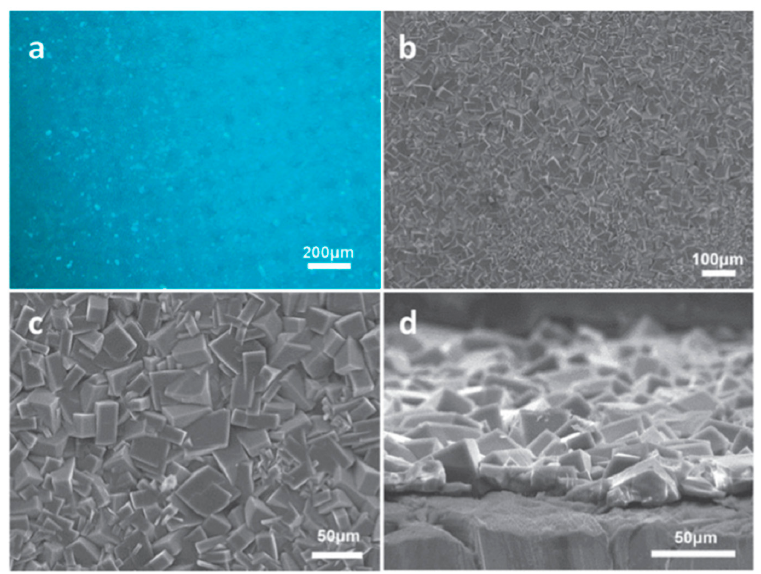
Figure 3. Leica picture of ( a ) the Ni 2 (L-asp) 2 (bipy) membrane; SEM pictures of ( b , c ) surface and ( d ) a cross section of the Ni 2 (L-asp) 2 (bipy) membrane. Reprinted with permission from Reference [55]. Copyright 2013 the Royal Society of Chemistry, (London, UK).